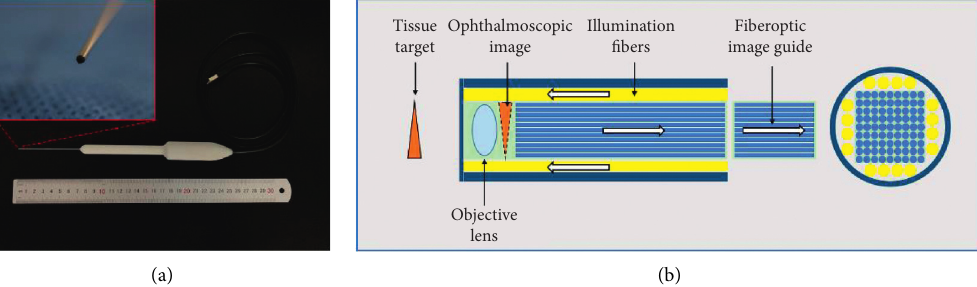
Figure 2: Structure of the portable endoscope. (a) Prototype overall view of the portable endoscope, with a stainless steel tube (8centimeters in length, 19 gauge in diameter), a handle, and a USB interface. (b) Structural schematic diagram of the portable endoscope. A camera module and illumination fibers lie inside the steel tube. The illumination source is supplied from the built-in LEDs through plastic optical fibers. The camera module equipped in the handle can compose, capture, and transmit images. The images were transmitted to the PC through a fiberoptic image guide. USB: Universal Serial Bus, LED: universal serial bus.